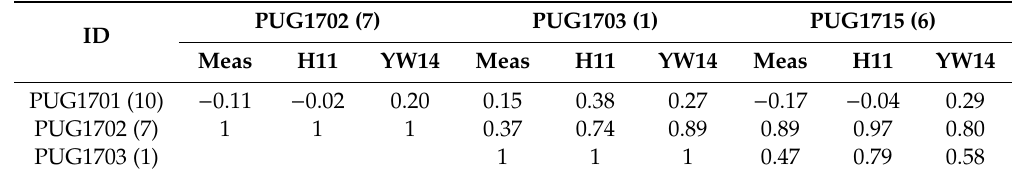
Table A4. Like Table A2 for San Juan